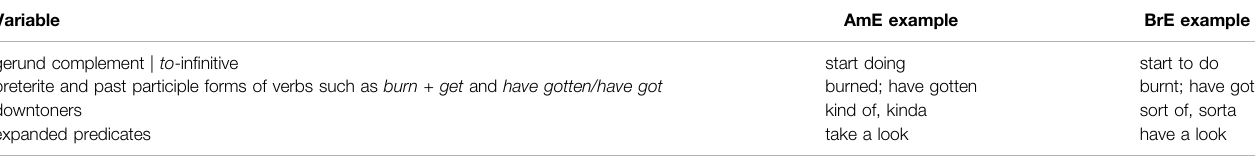
TABLE 2 | The grammatical variables used in the study.